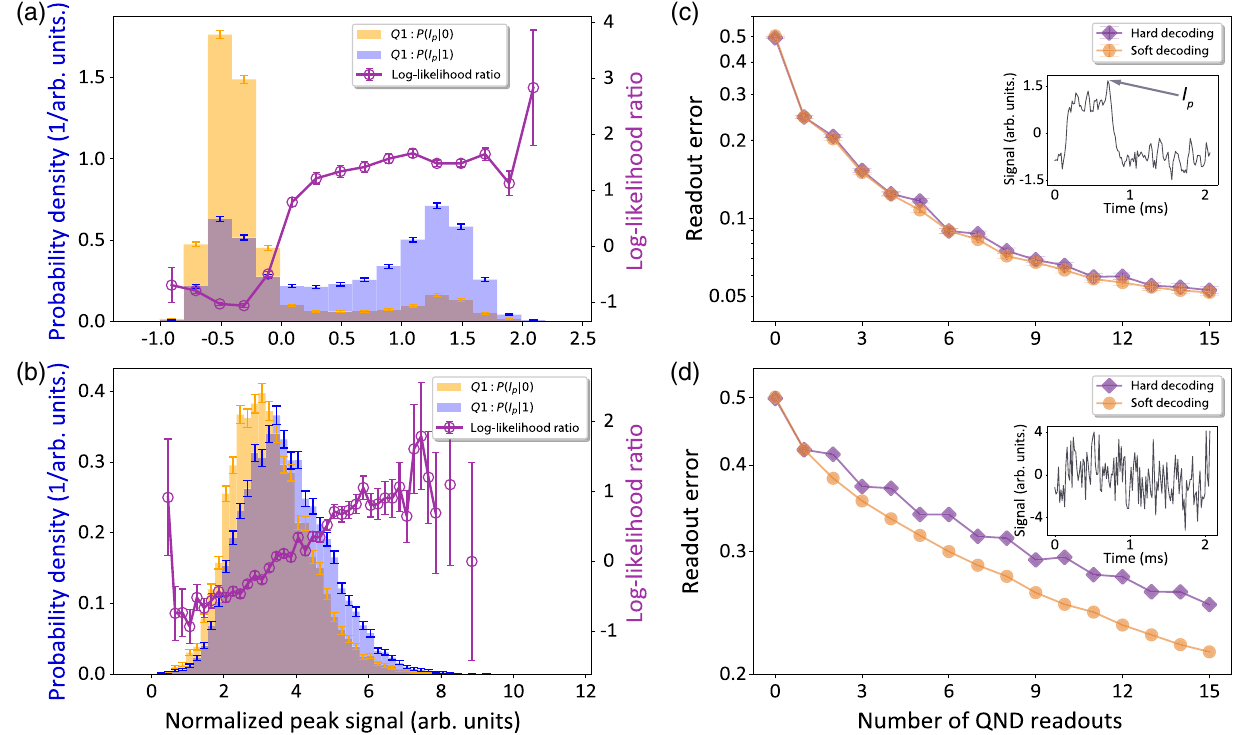
FIG. 3. (a) Empirically measured distributions P ð I p j 1 Þ and P ð I p j 0 Þ of the peak sensing dot signal I p in arbitrary units for preparation of Q 1 in j 1 i (blue histograms) and in j 0 i (yellow histograms), respectively. The distributions are obtained for the readout time that minimizes the single-repetition readout error (see Appendix D). Because of the bimodal features of the two distributions, the log- likelihood ratio λ ð I p Þ is approximately a step function (magenta curve). (b) Same dataset as in (a) but with artificially added Gaussian white noise. Here, the two distributions largely overlap. As a result, the log-likelihood ratio λ ð I p Þ is not a step function and different values of I p on one side of the threshold acquire different weights. This means that if the values of I p are thresholded at each cycle, useful information is discarded. (c),(d) Logical readout error rate without and with artificially added white noise. When the log- likelihood ratio λ ð I p Þ approximates a step function, there is little advantage in using soft decoding. When the log-likelihood ratio λ ð I p Þ strongly deviates from a step function, soft decoding reduces the number of repetitions required to achieve a given error rate. Insets: Example readout traces containing a tunnel event without or with added Gaussian white